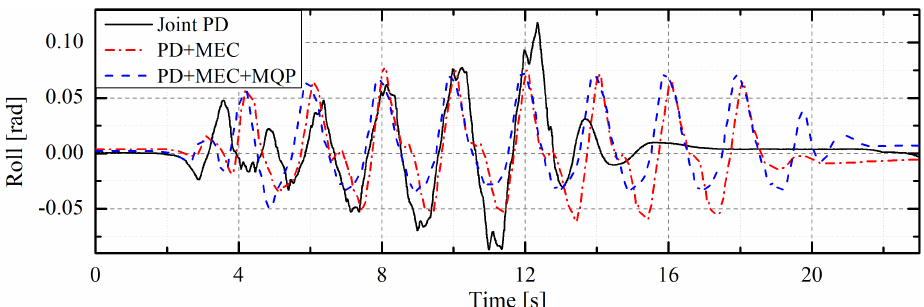
Figure 9. Comparison of the roll angle profiles of the quadruped platform with the proposed joint PD controller (black solid line), PD + MEC controller (red dashed dot line), and PD + MEC + CD controller (blue dashed